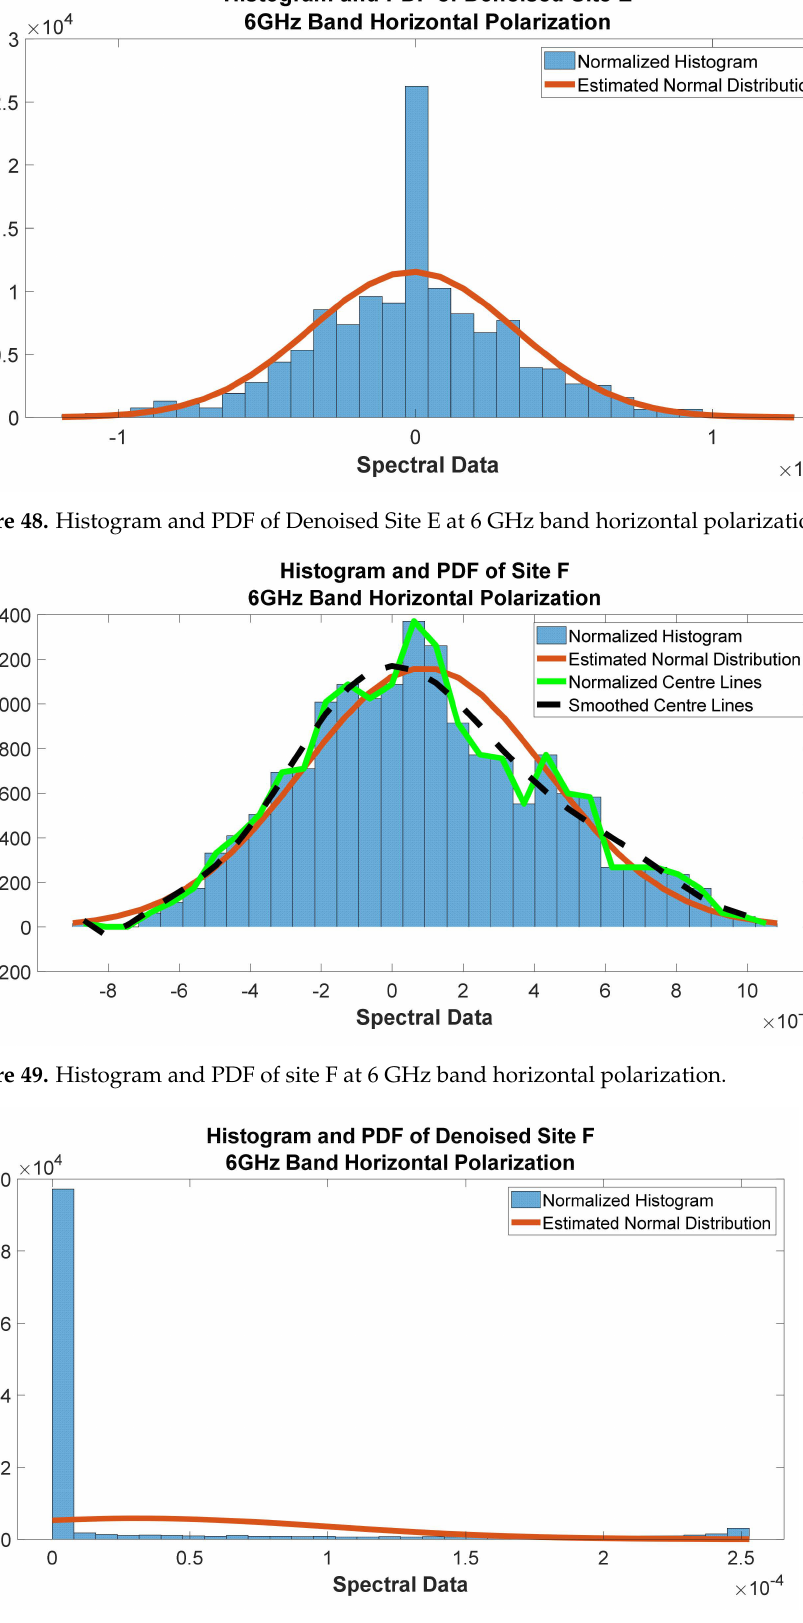
Figure 50. Histogram and PDF of Denoised Site F at 6 GHz band horizontal